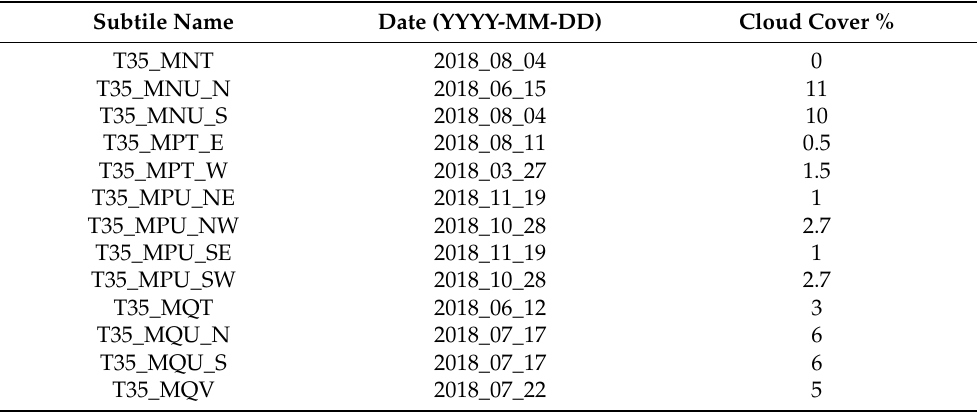
Table 2. List of S2 sub-tiles used for this